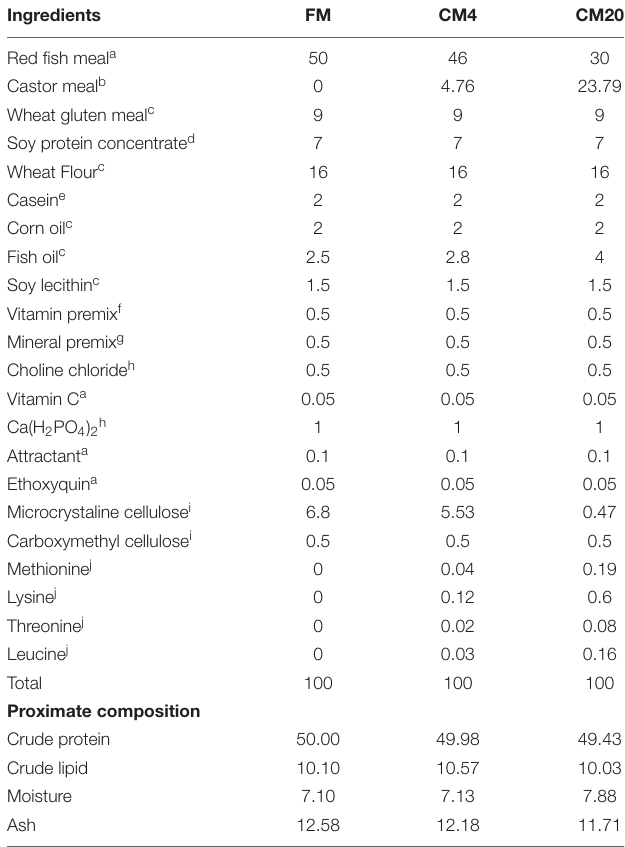
TABLE 1 | Formulation and proximate composition of experimental diets (% dry